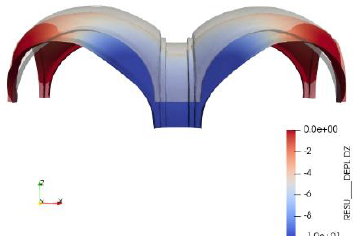
Figure 9. Imposed 10 mm displacement of the central column.